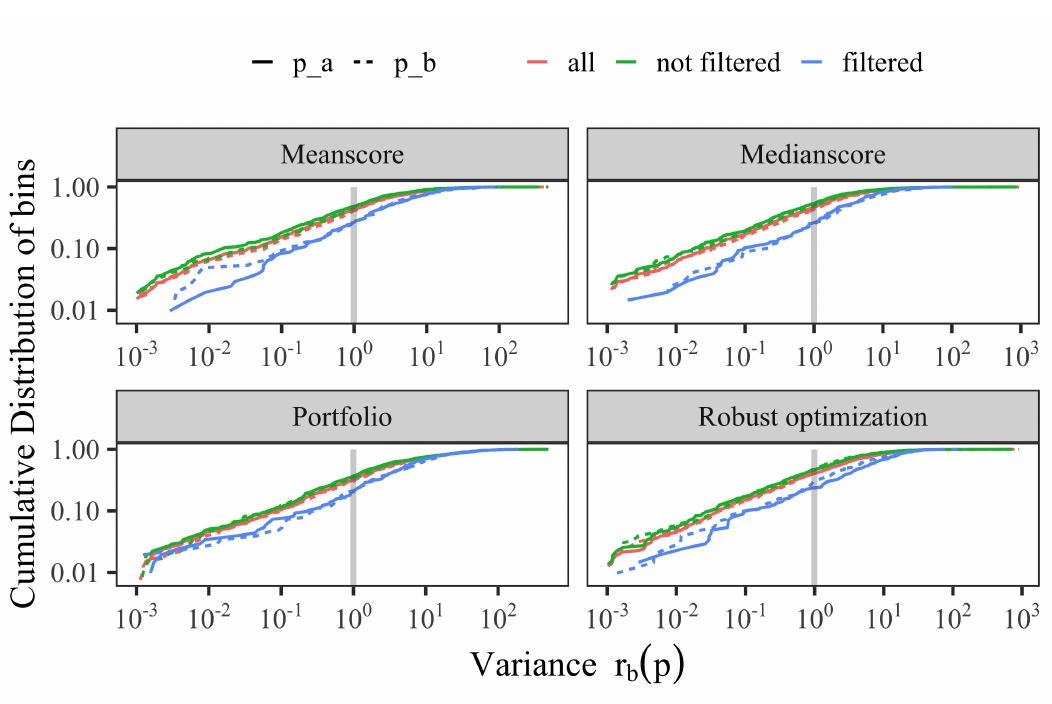
Figure 14: Same as Figure 12 , but for the S HERPA dataset.